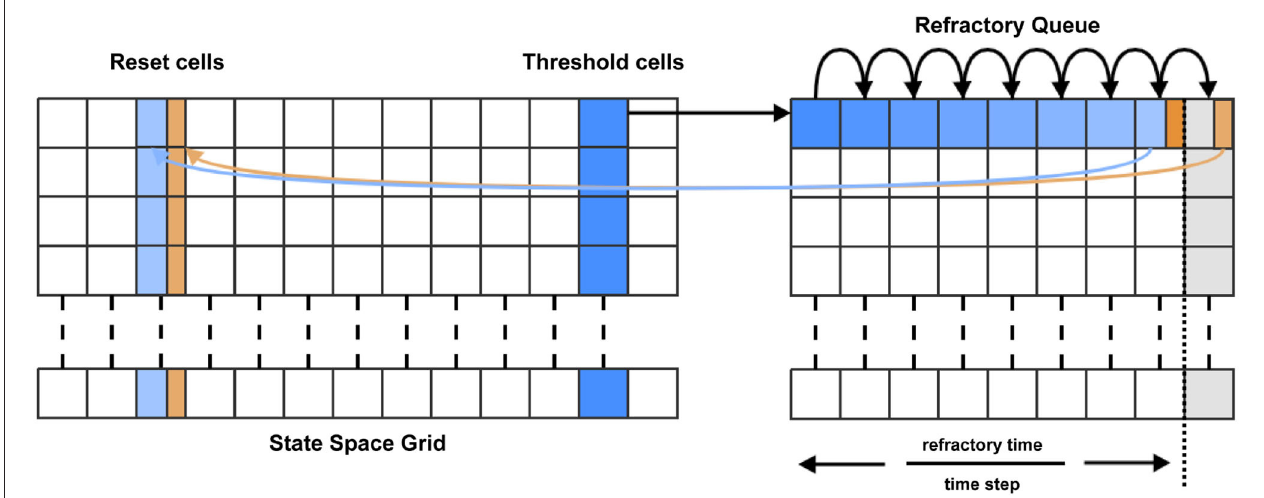
FIGURE 4 | For each time step, probability mass in the cells which lie across the threshold (threshold cells) is pushed onto the beginning of the refractory queue. There is one queue per threshold cell. During each subsequent time step, the probability mass is shifted one place along the queue until it reaches the penultimate place. A proportion of the mass, calculated according to the modulo of the refractory time and the time step, is transferred to the appropriate reset cell. The remaining mass is shifted to the final place in the queue. During the next time step, that remaining mass is transferred to the reset